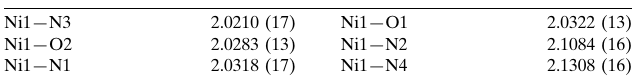
Selected bond lengths (A˚